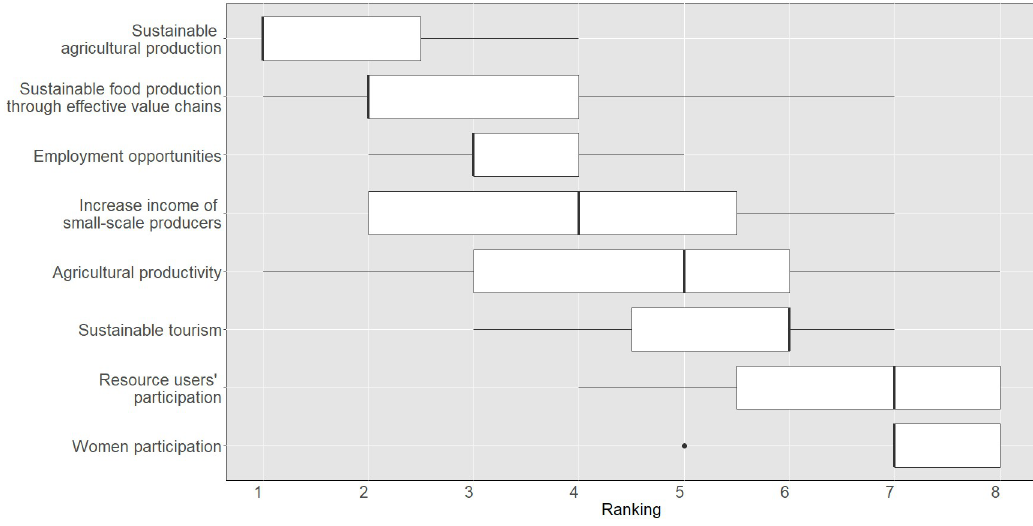
Fig 3. Prioritisation of socio-economic SDG targets for Apokoronas. KW after the first round was 0.53 (p < 0.001).